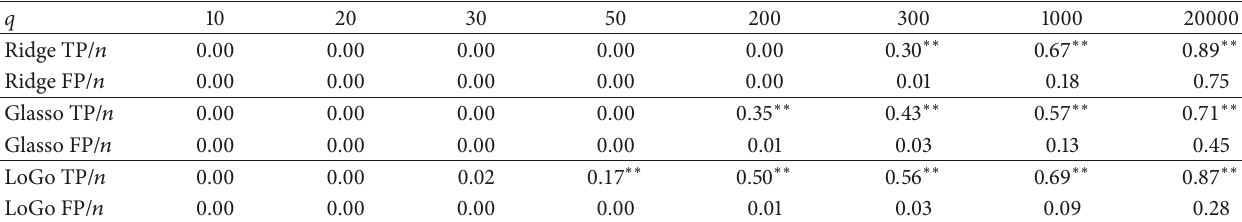
Table 4: Causality network validation with conditional transfer entropy validation at 1 % Bonberroni adjusted 𝑝 value . Fraction of true positive (TP /𝑛 ) and fraction of false positive (FP /𝑛 ), statistically validated, causality links for the three models, and different time series lengths. The table reports only the case for the parameter 𝛾 = 0.1 .